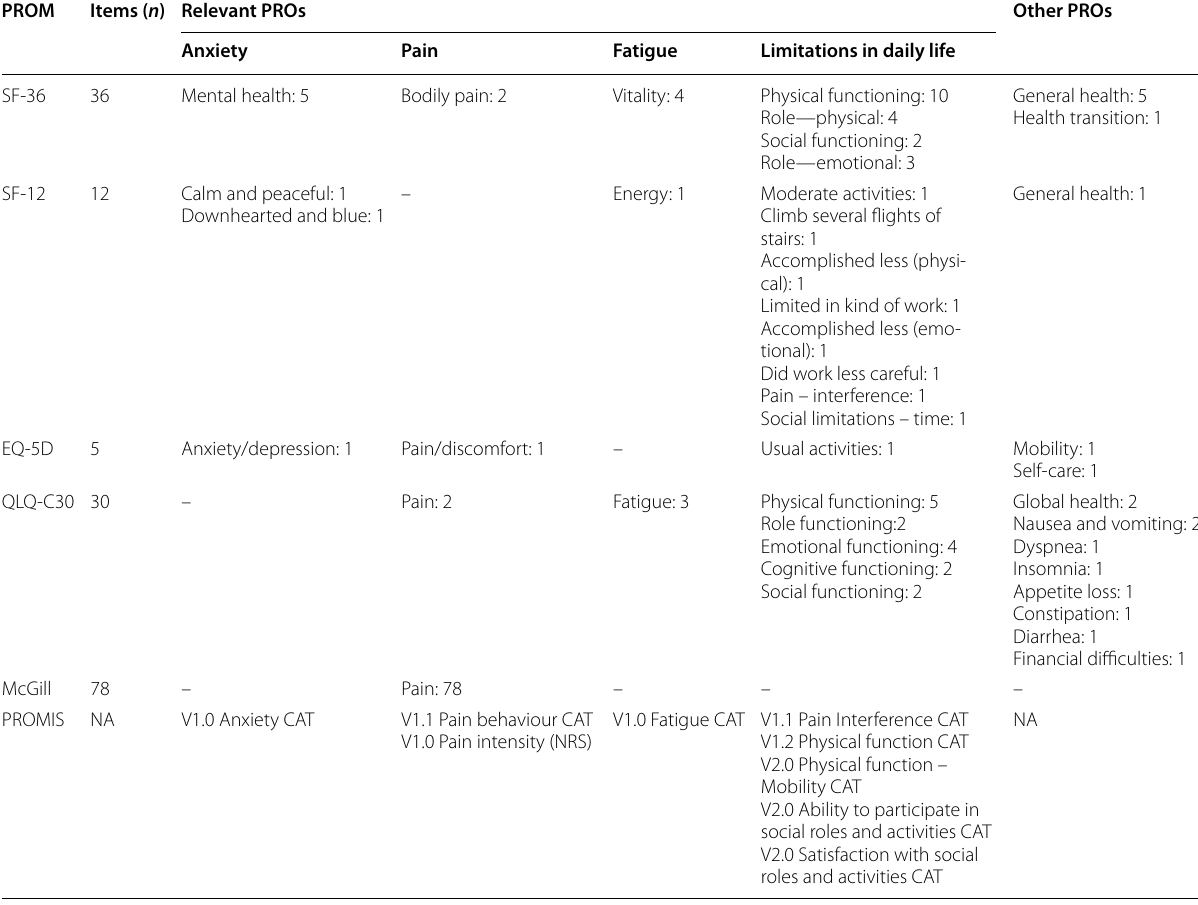
Table 3 PROMs and their (sub)domains potentially assessing relevant